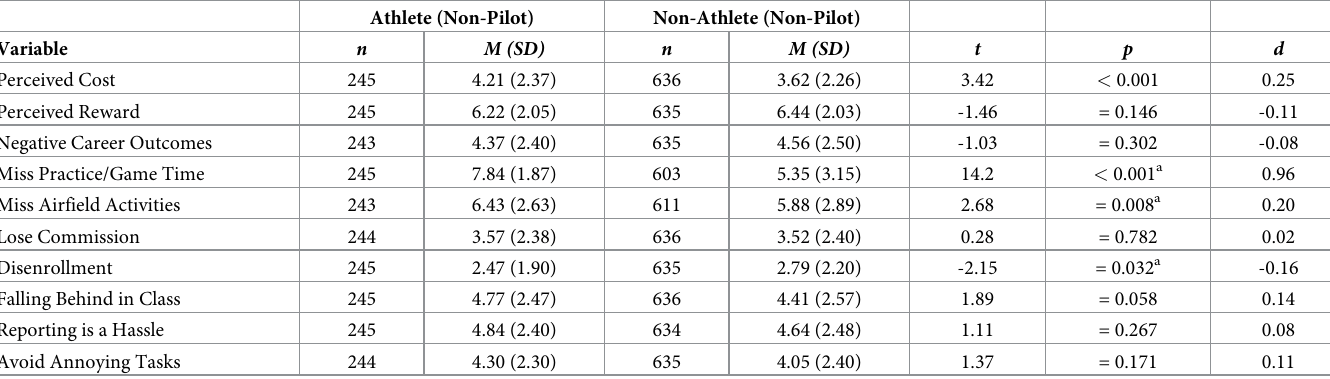
Table 4. Perceived cost and reward as a function of intercollegiate athlete status.